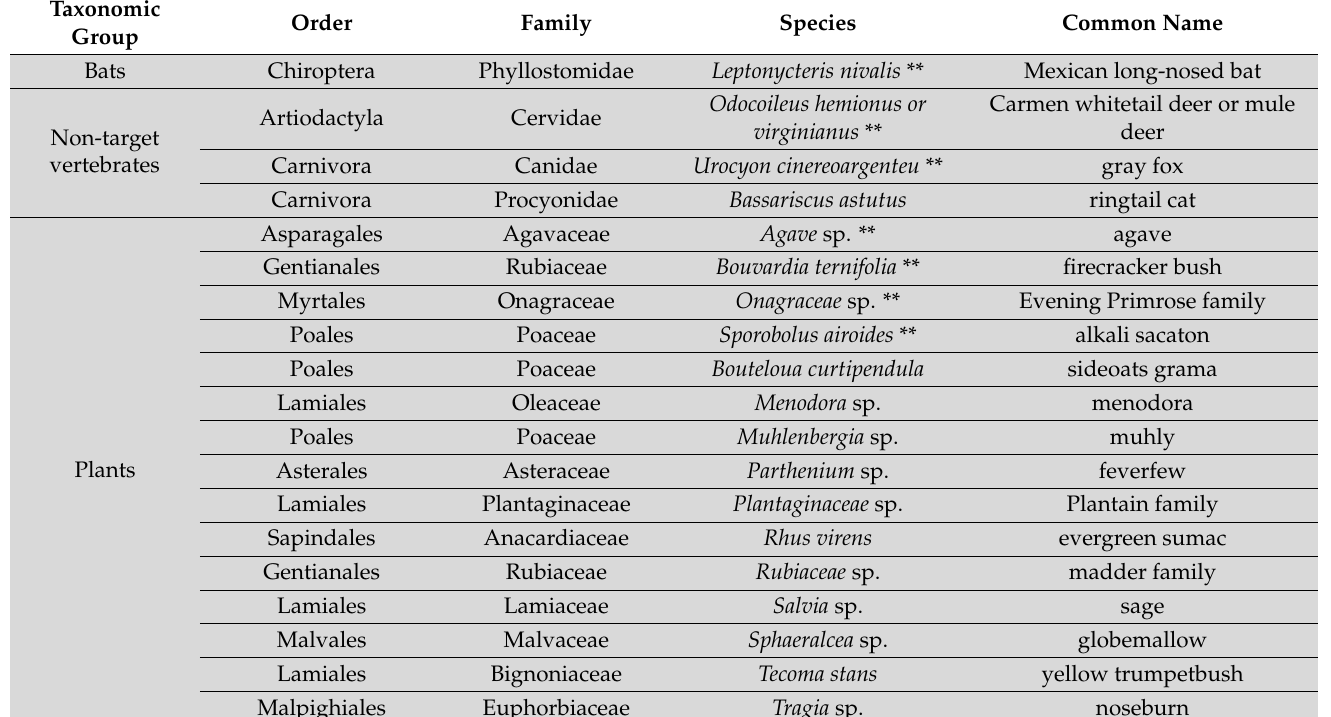
Table 5. Taxonomies derived from DNA metabarcoding via multiplex PCR of agave flowers visited by L. nivalis . Taxa observed more than once among biological and technical replicates of a plant are noted by **. All taxa in grey have been validated as occurring in the study area. BioSample accession numbers are in Table